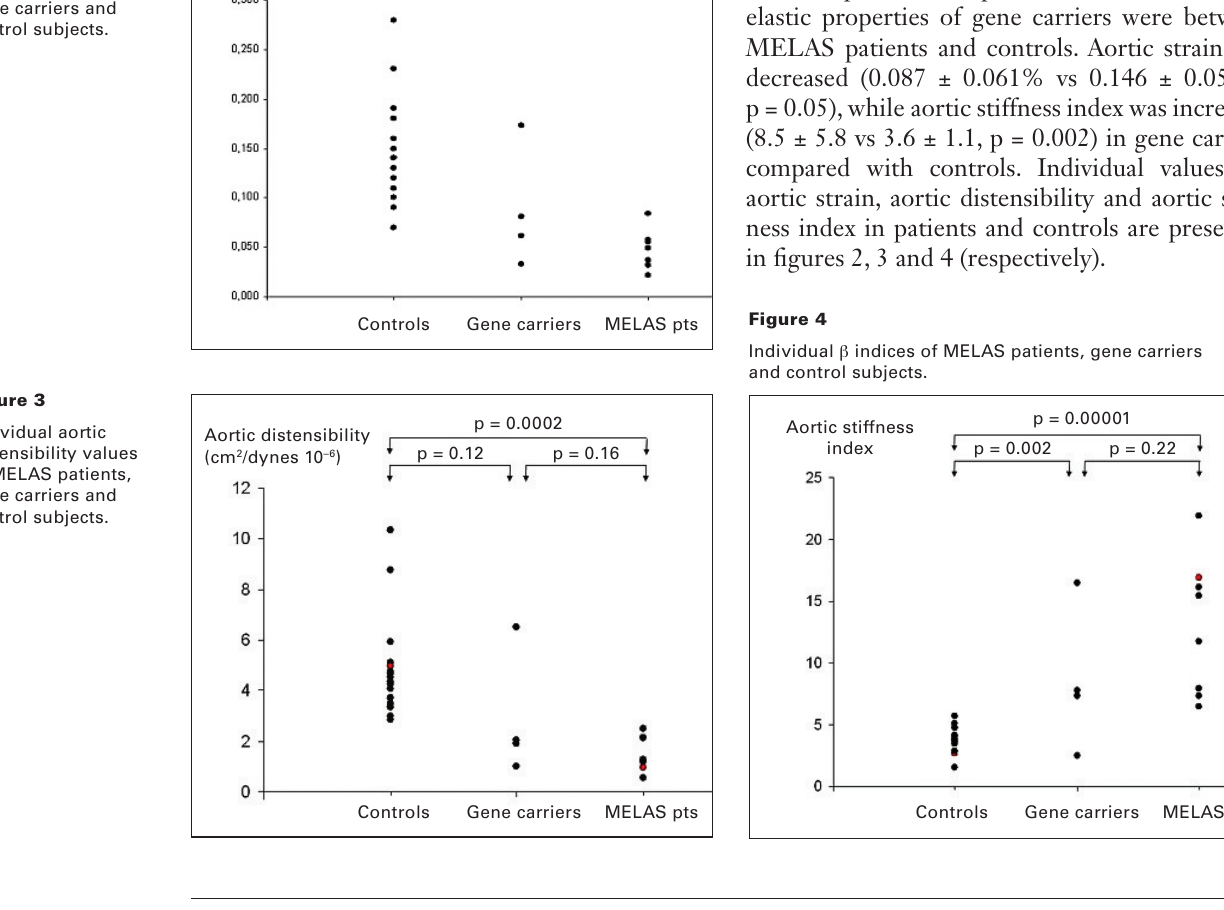
Individual aortic strain values of MELAS patients, gene carriers and control subjects.